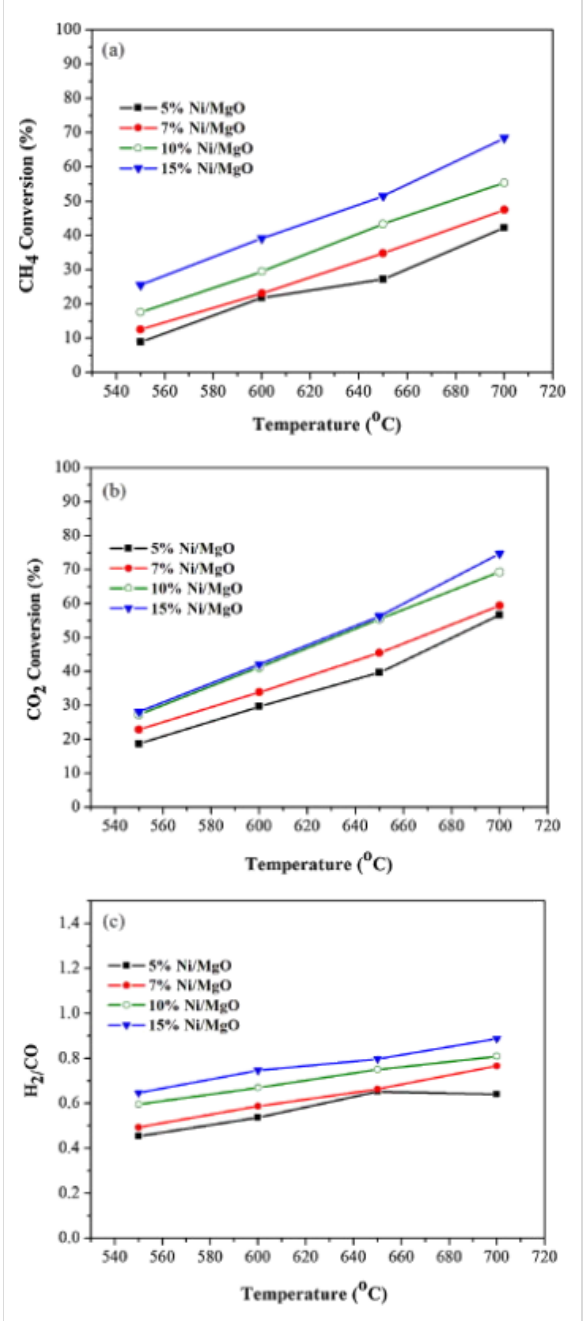
Figure 10: (a) CH 4 conversion, (b) CO 2 conversion, (c) H 2 /CO ratio of catalysts with different nickel loadings in the DRM reaction, CH 4 /CO 2 1:1 and gas hourly space velocity (GHSV) of 1.8 × 10 4 mL/h·g cat. Reprinted with permission from [108], copyright 2014 Elsevier.